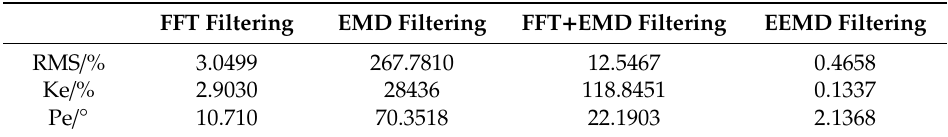
Table 3. Analysis table of integral result error.